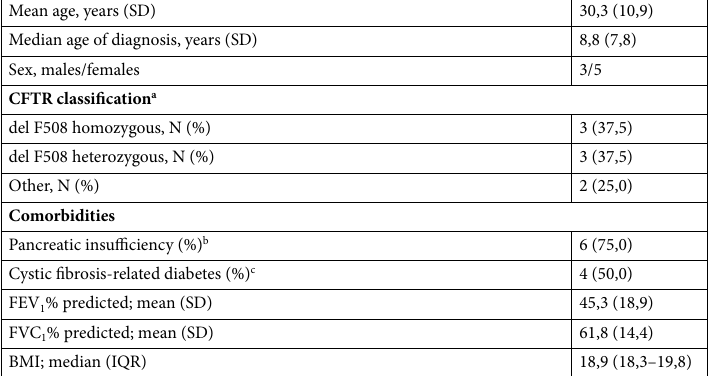
Table 2. Characteristics of the eight patients diagnosed at the institute of tuberculosis and lung diseases between 2012 and 2019. a Homozygous: both alleles containing the delta F508 mutation; Heterozygous: one allele containing the delta F508 mutation; Other: alleles containing mutations that are different. b Pancreatic insufficiency: use of pancreatic enzymes. c Cystic fibrosis-related diabetes: use of